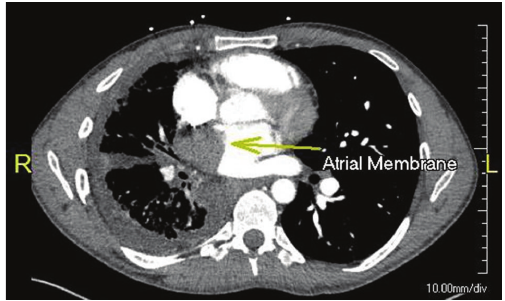
Figure 3: Axial plane showing vertical membrane (yellow arrow) in left atria obstructing right pulmonary venous flow.